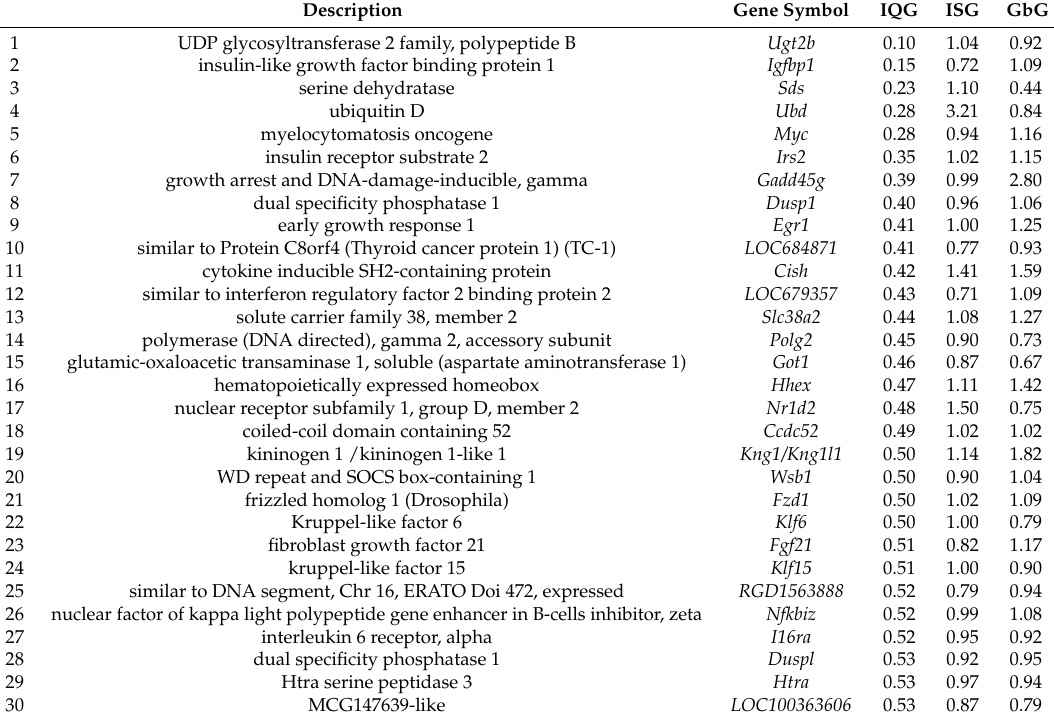
Table 6. Down-regulated genes differentially expressed in the liver tissue of high fat diet rats treated with insect glycosaminoglycan over a one month